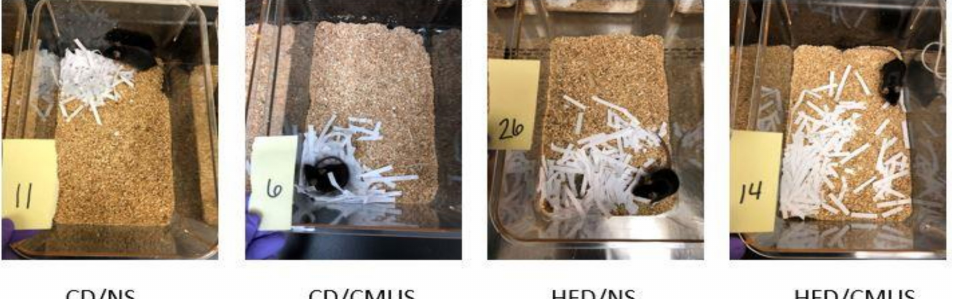
Figure 13. Representative nests built by mice in the experimental conditions. Mice given HFD built significantly worse nests than those given CD ( p < 0.05). CMUS mice built significantly better nests than those under NS ( p < 0.05). 11—Control Diet, No Stress; 6—Control Diet, Chronic Mild Unpredictable Stress; 26—High Fat Diet, No Stress; 14—High Fat Diet, Chronic Mild Unpredictable Stress.